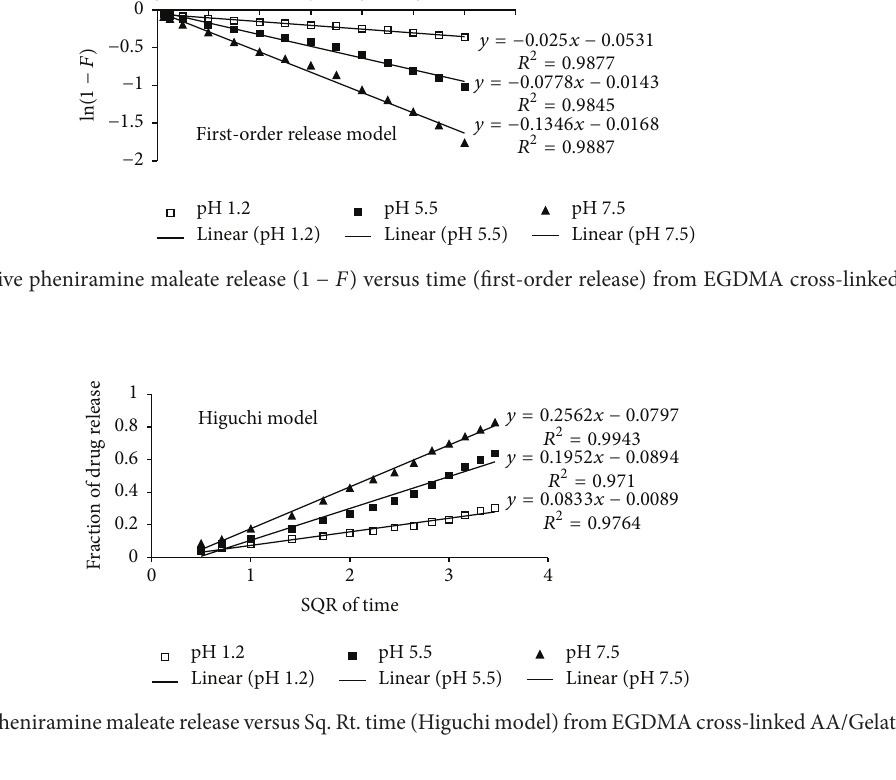
Table 8: Effect of different concentration of acrylic acid on drug release mechanism of AA/Gelatin hydrogels in solutions of different pH values using EGDMA as cross-linking agent (0.7% of acrylic acid). Sample codes